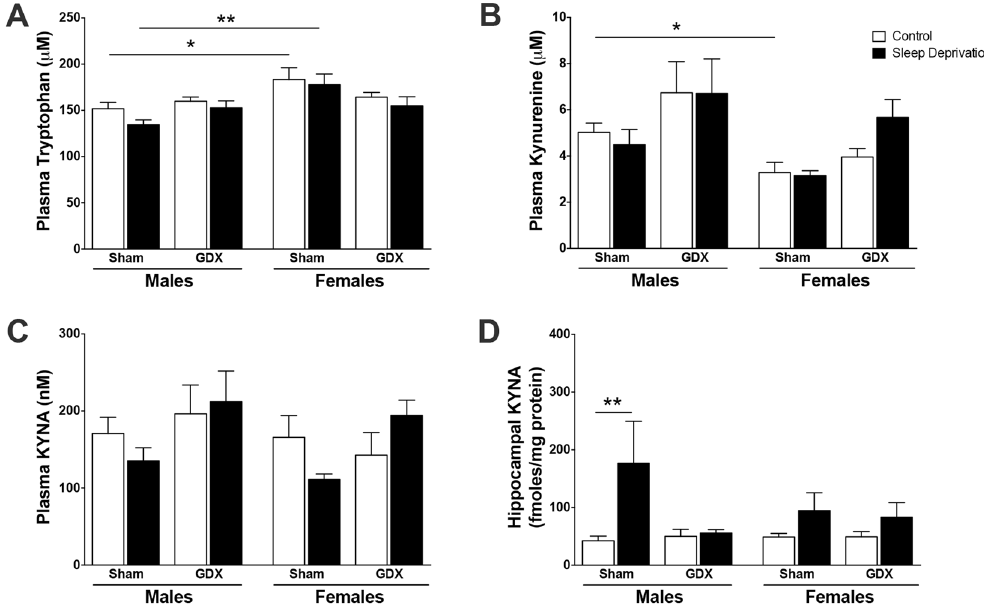
Figure 6. Gonadectomy (GDX) in male animals attenuates an elevation in hippocampal KYNA levels after sleep deprivation. Sham-operated or GDX male and female animals were sleep deprived for 6 h from ZT 0 to ZT